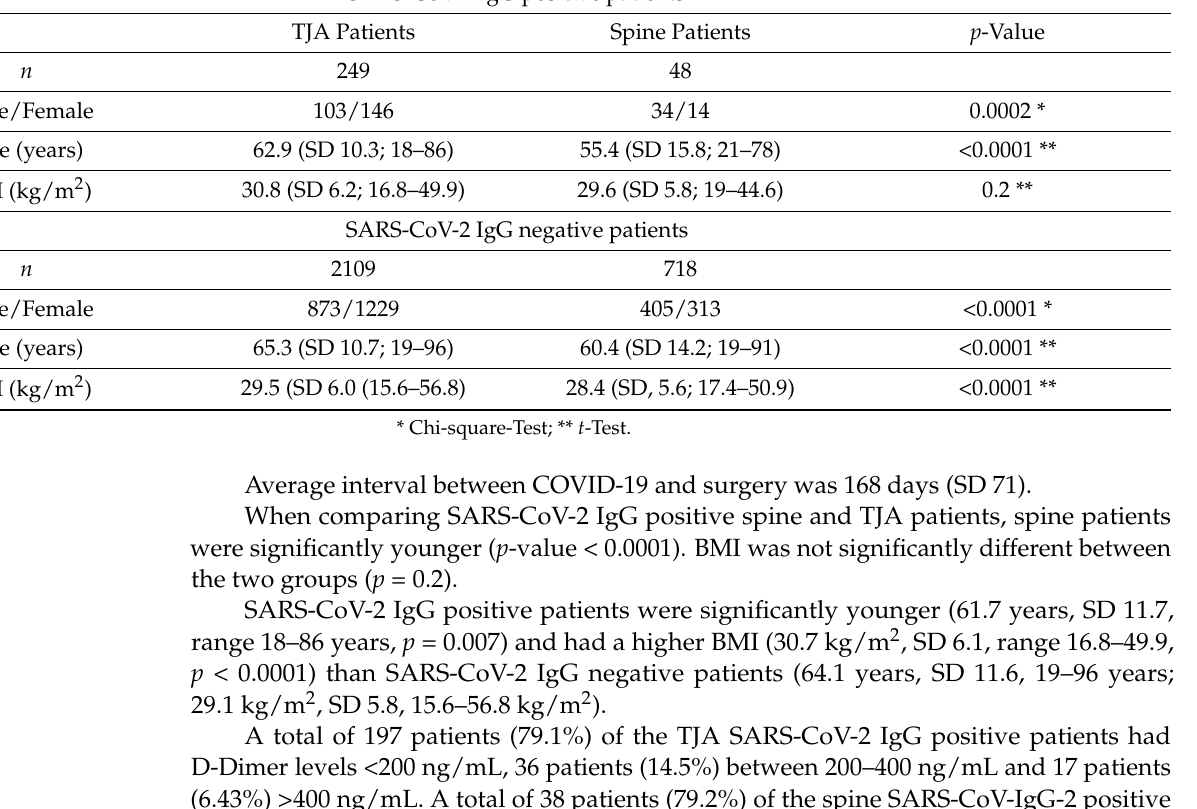
Table 1. Demographic information of the groups. SARS-CoV-2 IgG positive patients TJA